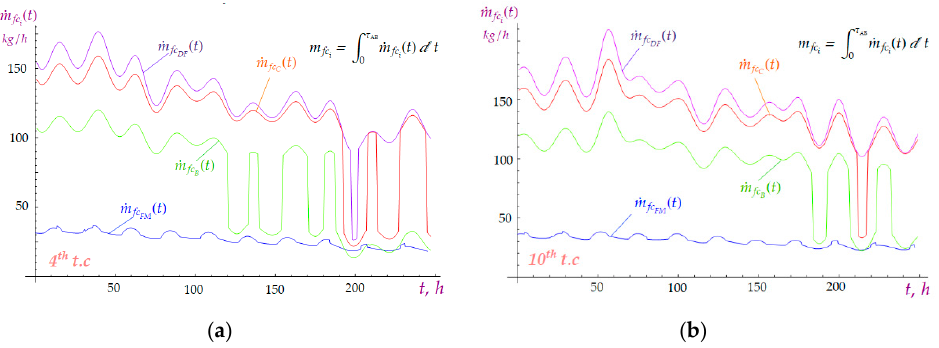
Figure 22. Fuel savings in air conditioning systems of the ship ’s accommodation for 1th and 10th transport cycles during navigation of loaded ship from A to B for; ( a ) 1st and ( b ) 10th transport cycle. Fuel consumption accounting for the operation of the compressor plant to balance the occurring storage cooling load during navigation of a loaded ship for two characteris- tic transport cycles, through a one-year period, is illustrated in Figure 23.